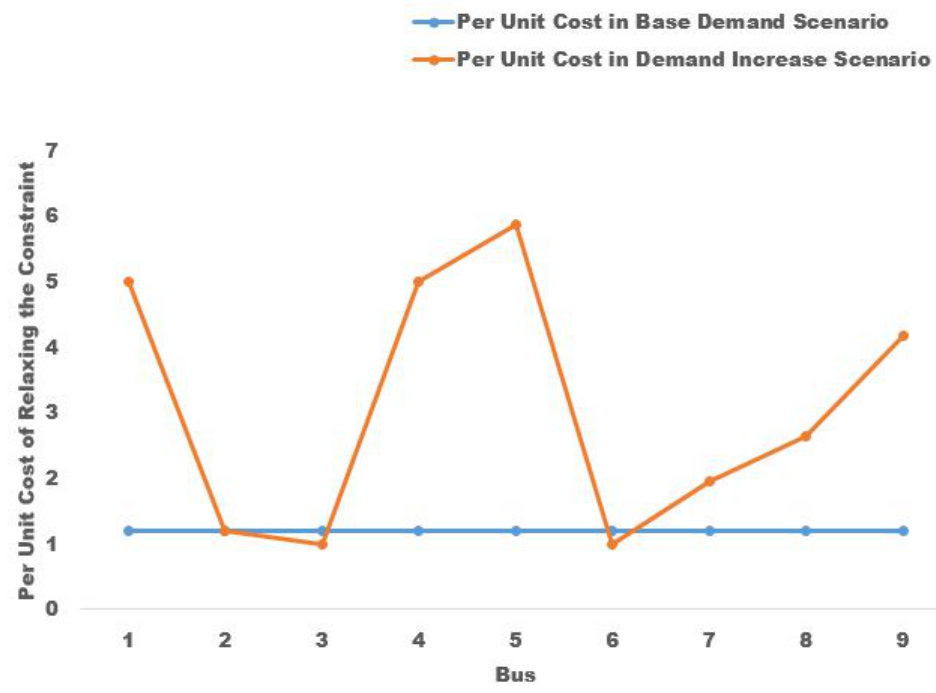
Figure 4. The per unit cost of relaxing the constraint in base and increased demand